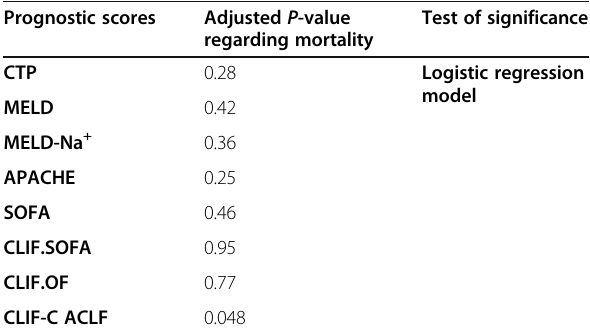
Table 7 Relation between prognostic scores and the detected mortality